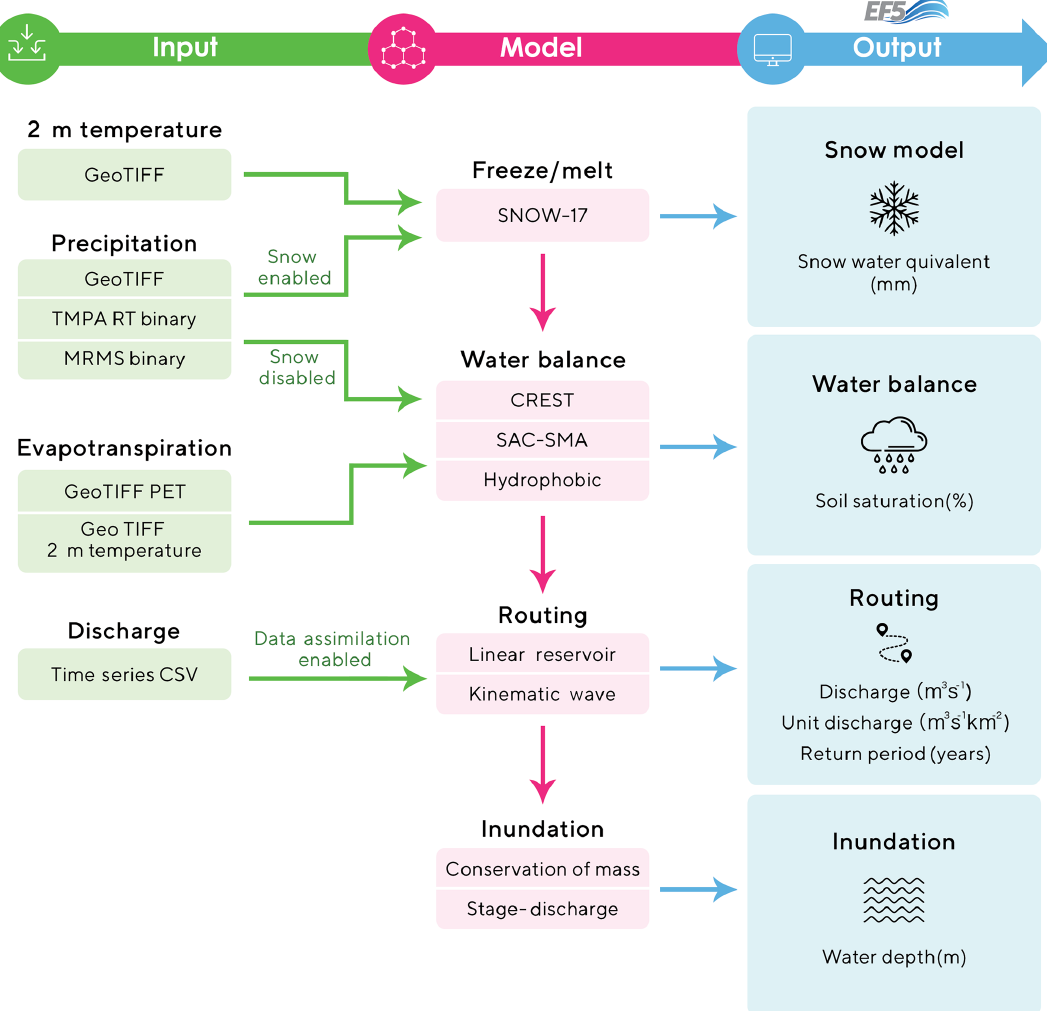
Figure 1. Flow chart illustrating the different modules and options available in EF5. The arrows show the paths available for input data to flow between the modules. The modules can be enabled or disabled from the control file to get the desired final model